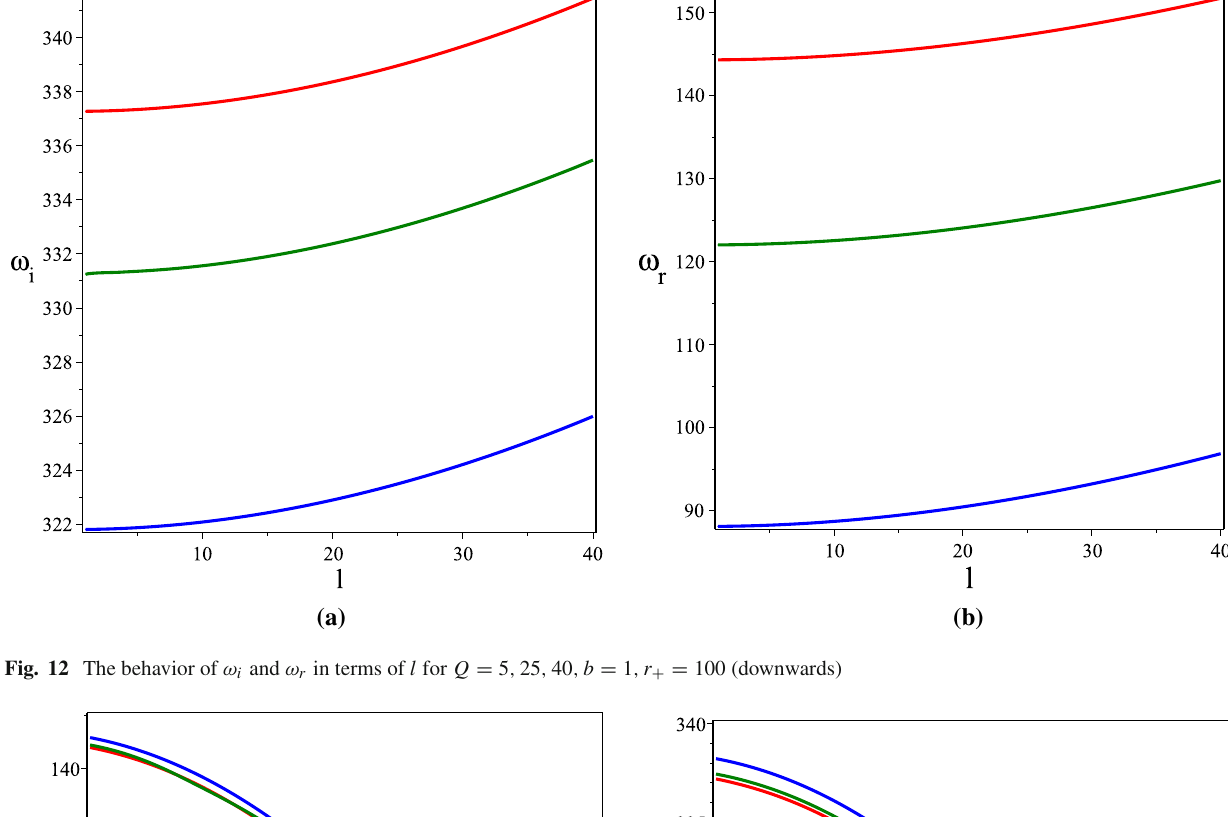
perturbations in isobaric process by fixing the pressure P to obtain the phase transitions between small-large black